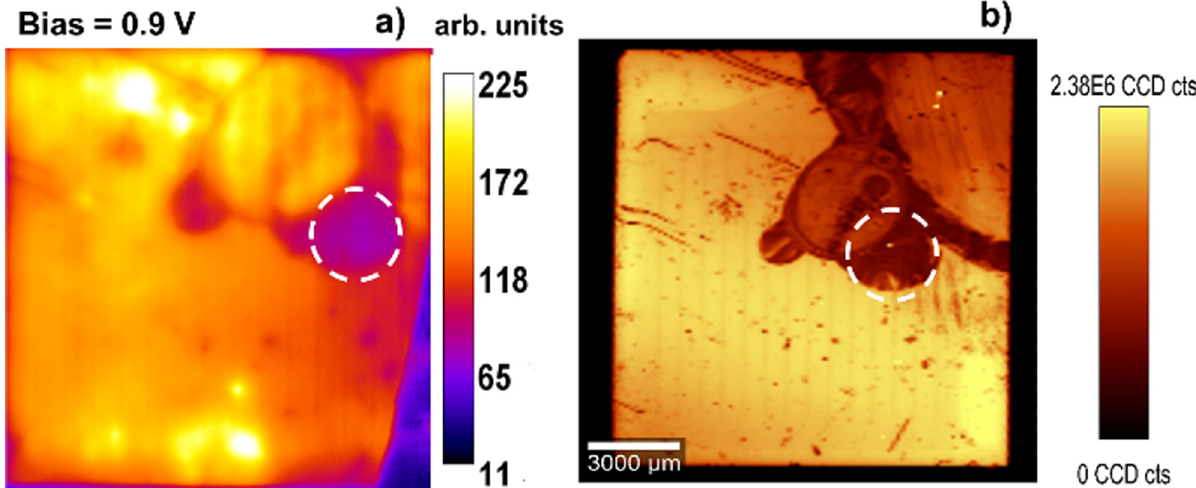
Fig. 4. (a) EL image of Si-IBC-1 at 0.9 V bias compared to (b) PL image obtained by m -confocal microscope, excitation wavelength is 532 nm. The white circle indicates the high electrical defect zone.